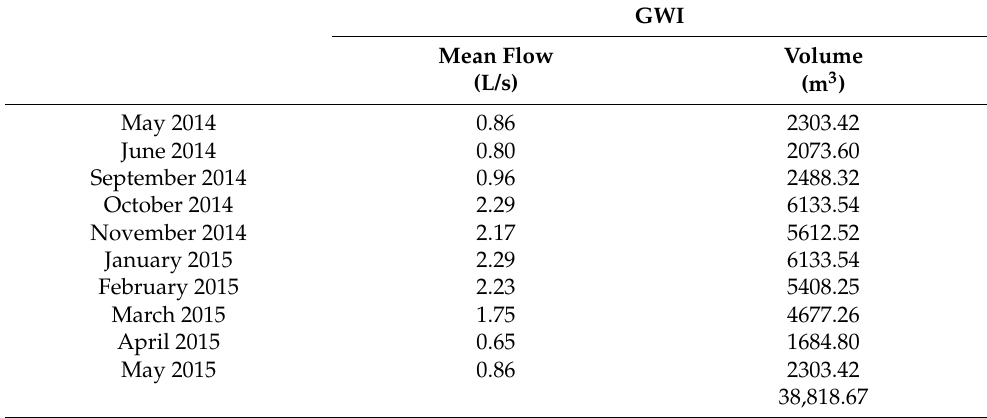
Table 3. Average monthly groundwater infiltration flow rates (GWI) and corresponding volumes.